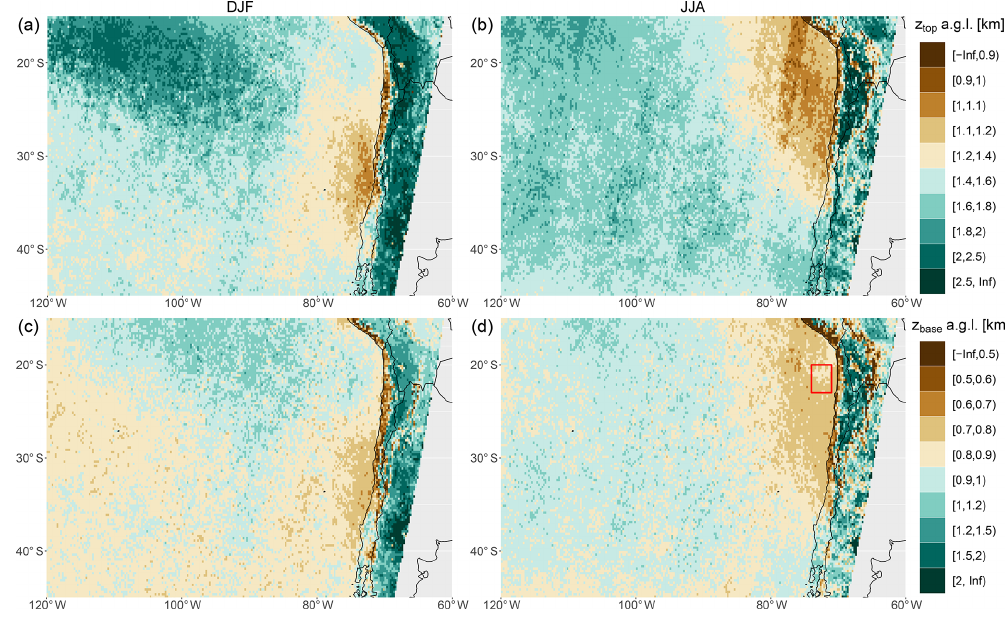
Figure 12. Median of z top (a, b) and z base (c, d) over a 16-year period (2001–2016) for austral summer (DJF, a and c ) and austral winter (JJA, b and d ) on a 0.25 ◦ × 0.25 ◦ longitude by latitude grid in the southeast Pacific. z base and z top are given above ground level (a.g.l.). The red rectangle (d) frames the region for which a time series of cloud heights is presented in Fig.